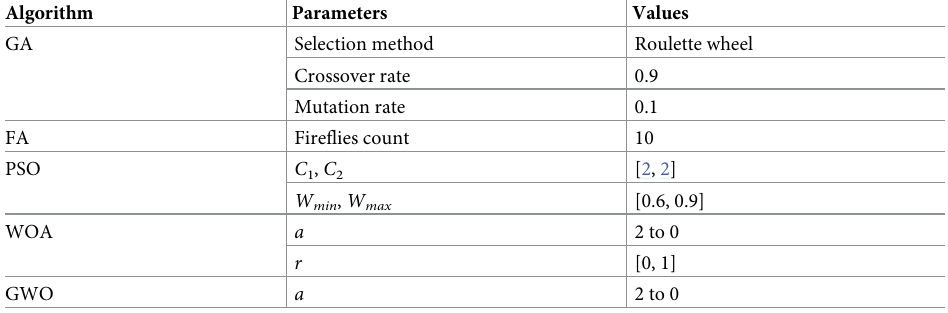
Table 5. Configuration parameters of the comparison